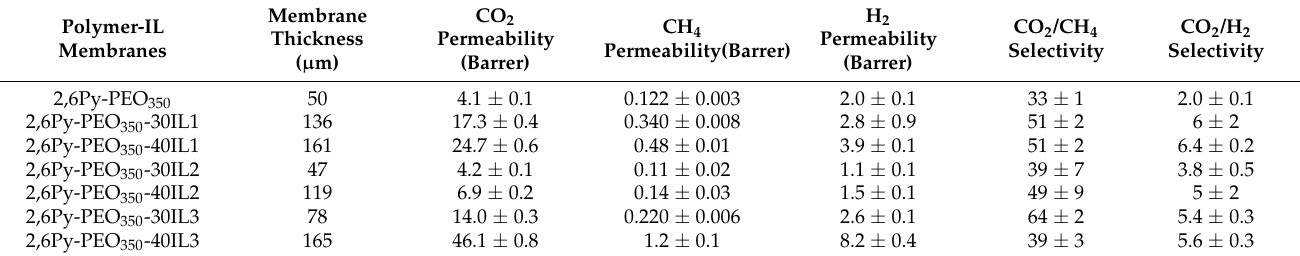
Table 1. Single gas permeability and CO 2 selectivity over other gases of the precursor polymer and